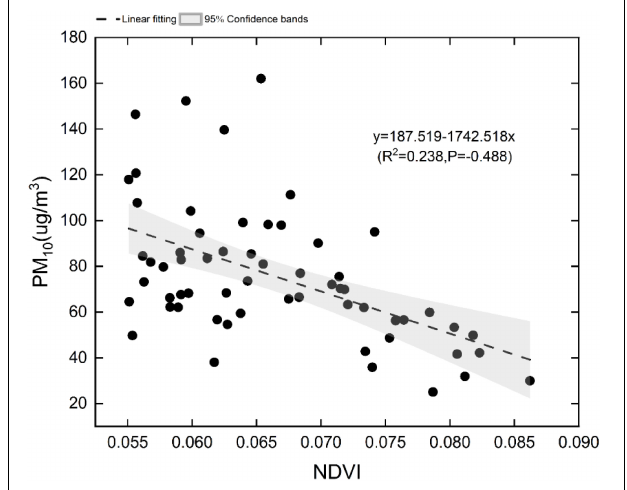
FIGURE 10 | A Scatter plot of NDVI and PM 10 in Alxa League from 2015 to